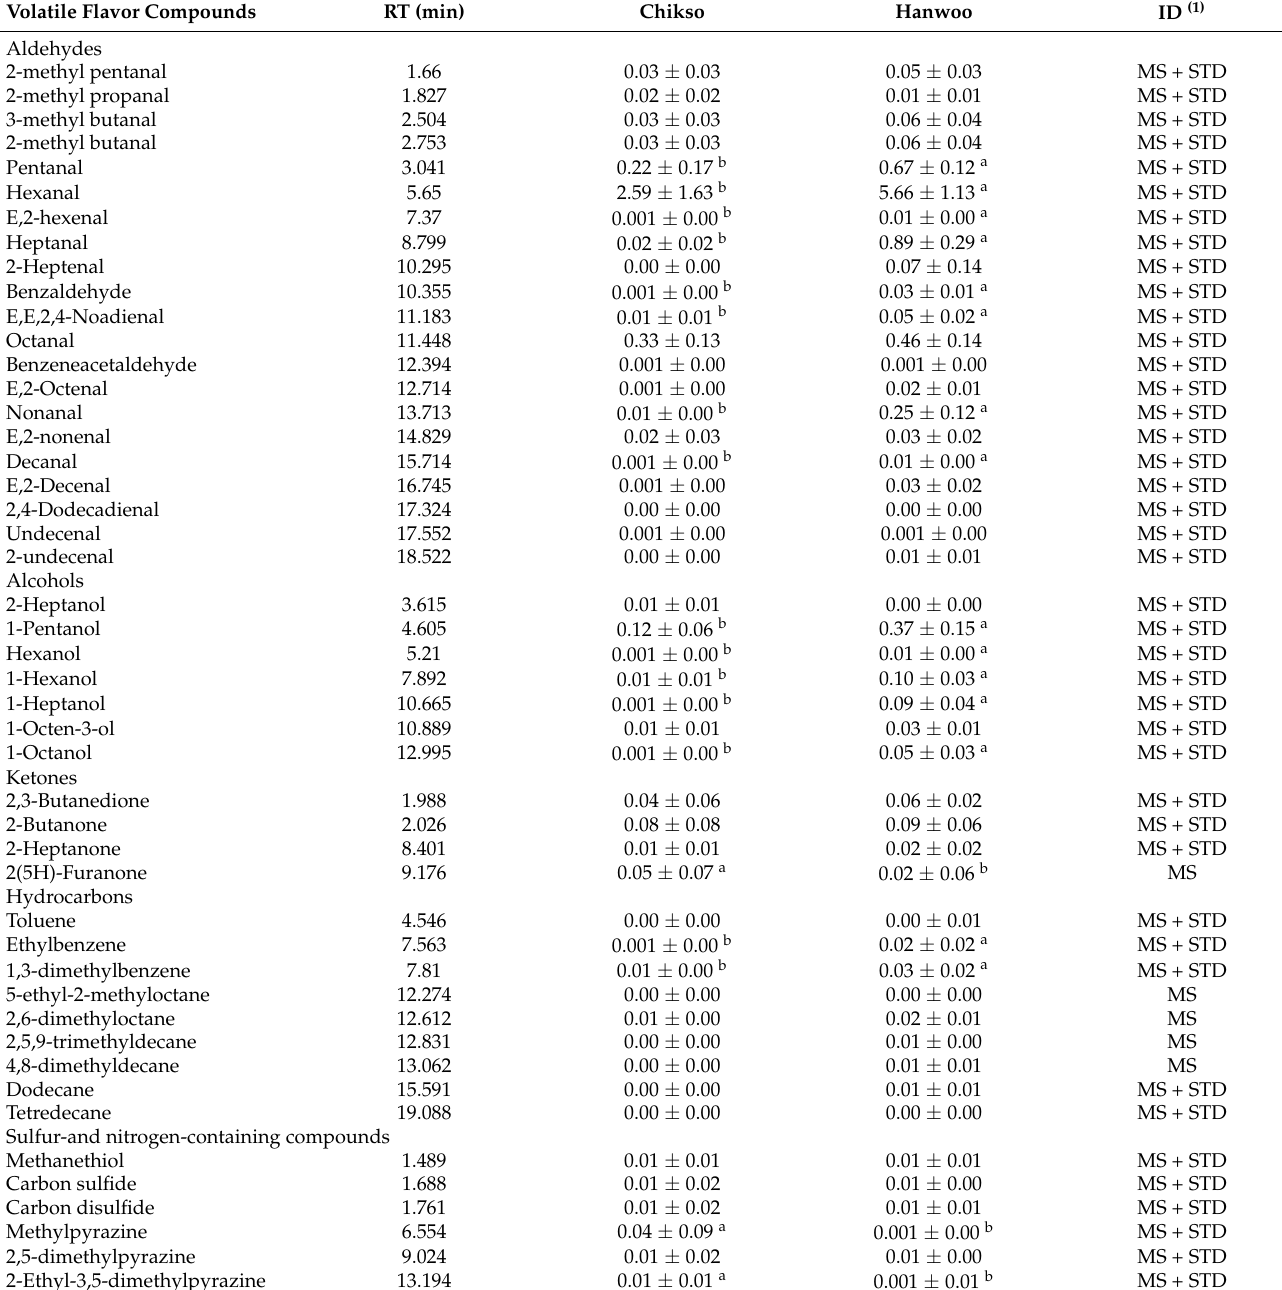
Table 5. Concentration ( µ g/g) of volatile flavor compounds in cooked Longissimus lumborum muscles from Chikso and Hanwoo under identical rearing